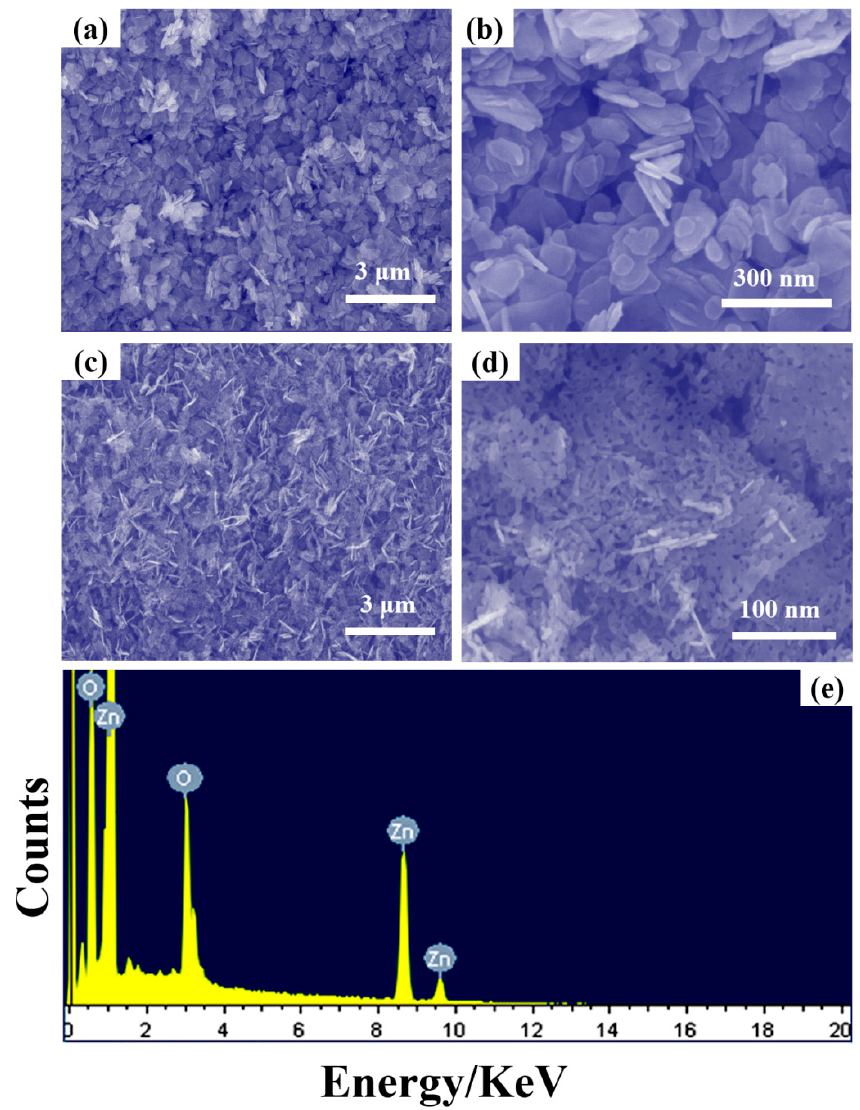
Figure 2. ( a ) Low-magnification SEM images of ZnO nanosheets without hydrothermal treatment. ( b ) High-magnification SEM images of ZnO nanosheets without hydrothermal treatment. ( c ) Low-magnification SEM images of ZnO nanosheets after hydrothermal treatment. ( d ) High-magnification SEM images of ZnO nanosheets after hydrothermal treatment. ( e ) SEM mapping of the porous ZnO nanosheets.